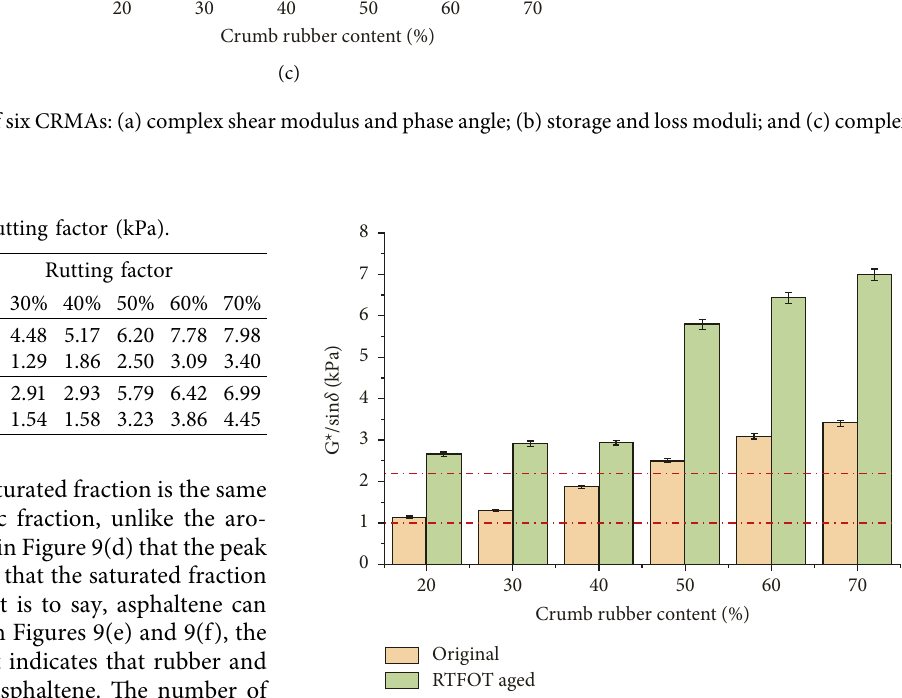
Figure 11: Effect of crumb rubber content on rutting factor (76 °